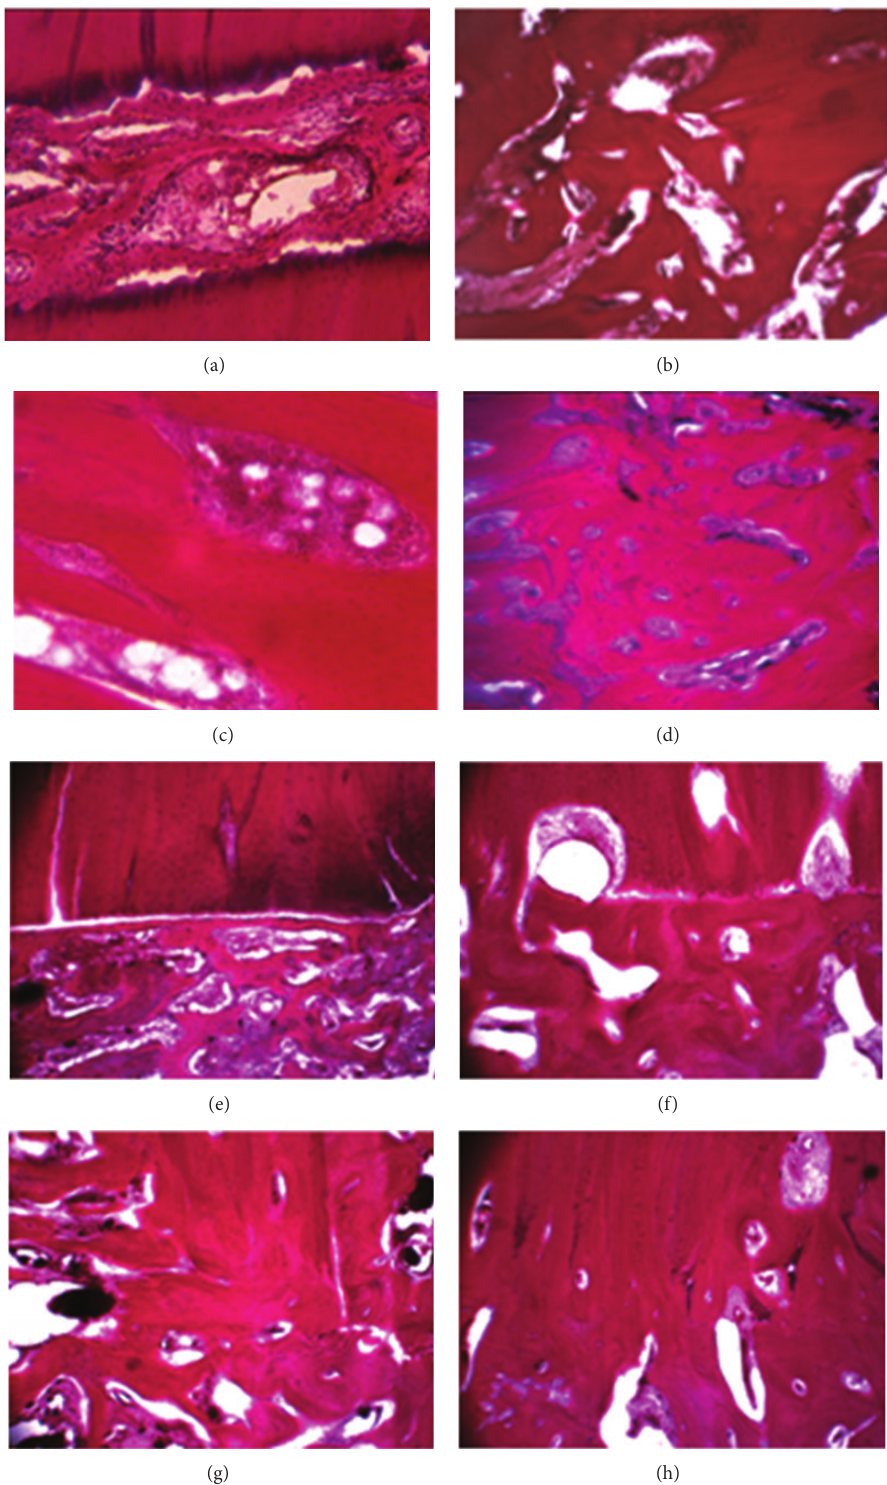
Figure 4: Microphotos of the intermediary regeneration areas. Group 1 (a–d) and group 2 (e–h): (a, e) day 14; (b, f) day 28; (c, g) day 45; and (d, h) day 75. Hematoxylin eosin staining. Magnification: (a, b, d–h) × 40 and (c) ×